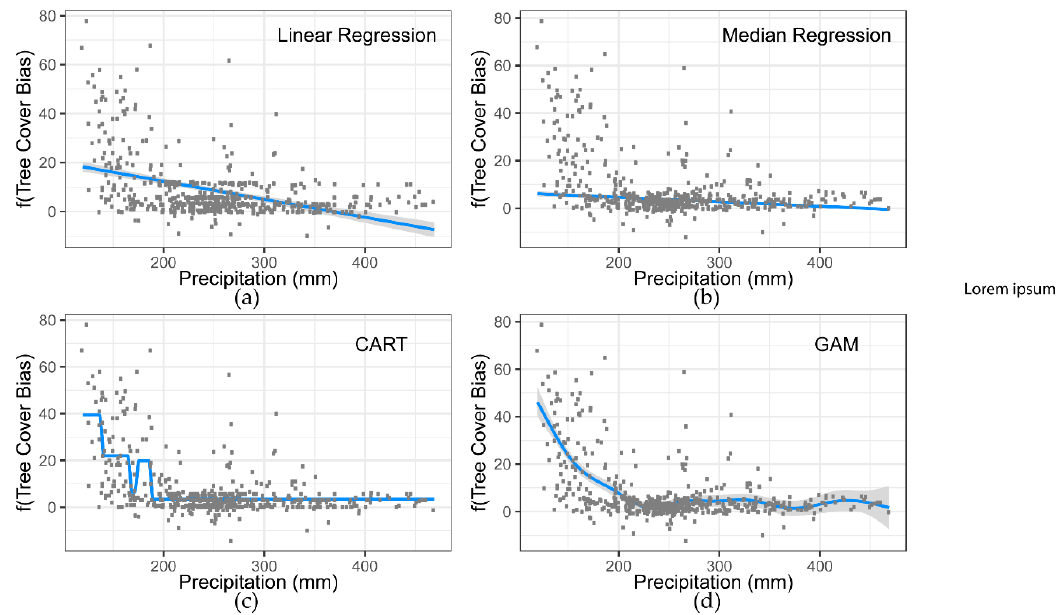
Figure 4. The fit of four different models ( a – d ) predicting tree cover bias (i.e., the difference between reference and GFC estimates), showing the conditional partial term for precipitation. Reference points are in gray, and the blue line shows the partial term prediction. The y-axis is the estimated bias residuals remaining after fitting the other predictor (elevation).